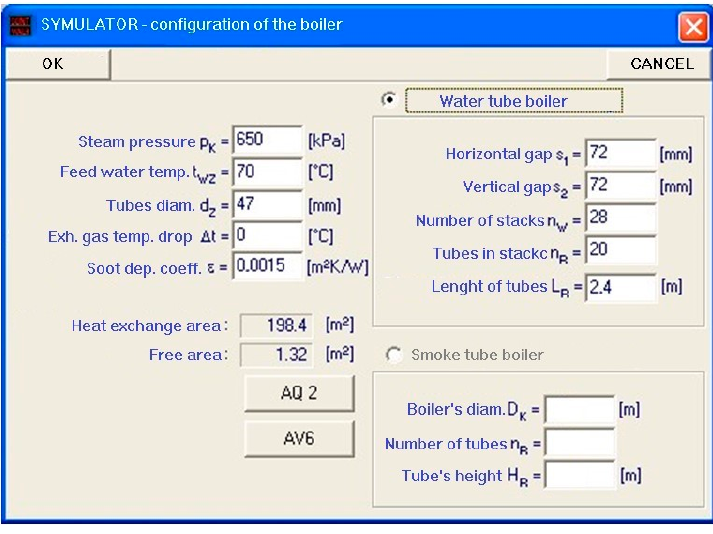
Figure 5. Data entry window for exhaust gas EGB.